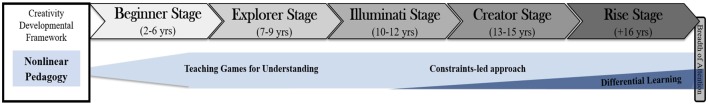
The nonlinear pedagogy assumptions embodied in the creativity training stages.